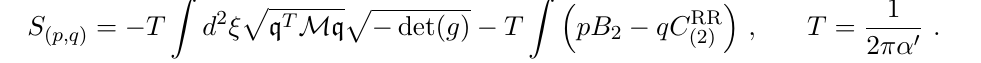
1 ; 0) and (0 ; 1) 5-branes. (a) The basis (cid:6) (cid:6) + c has a vanishing (cid:13)ux. (c) The (1 ; 0) ( (cid:0) 1 ; 0) + c (1 ; 0) ( (cid:0) 1 ; 0)